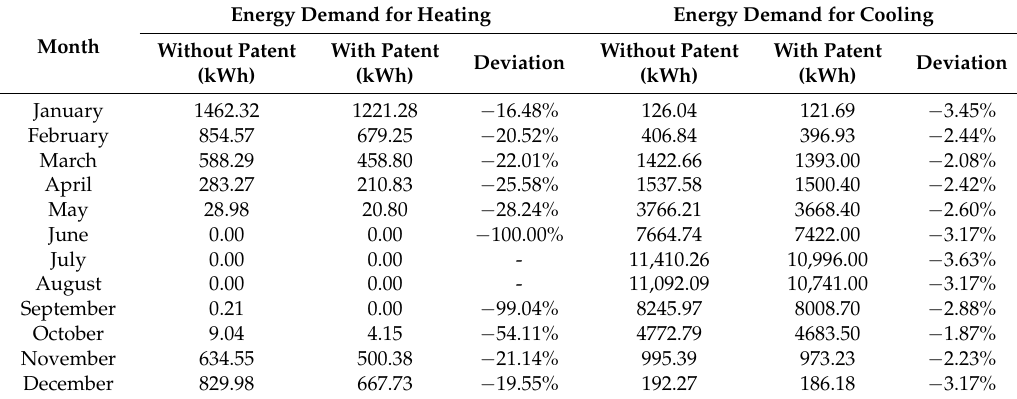
Table 7. Differential of energy demand between the case study without patent and the one with patent for the period of 2050.